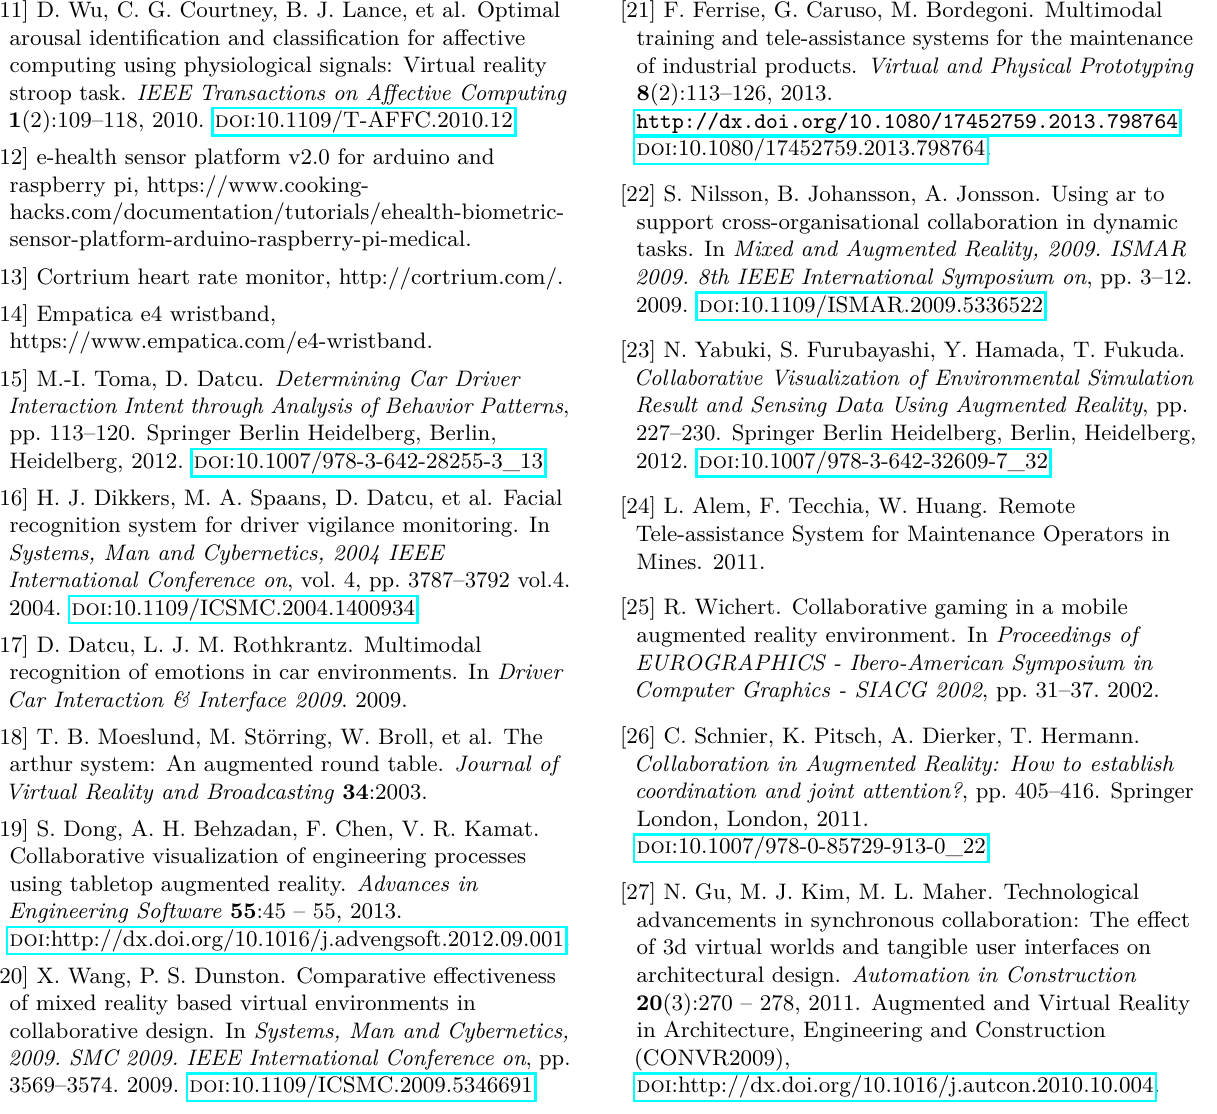
[11] D. Wu, C. G. Courtney, B. J. Lance, et al. Optimal arousal identification and classification for affective computing using physiological signals: Virtual reality stroop task. IEEE Transactions on Affective